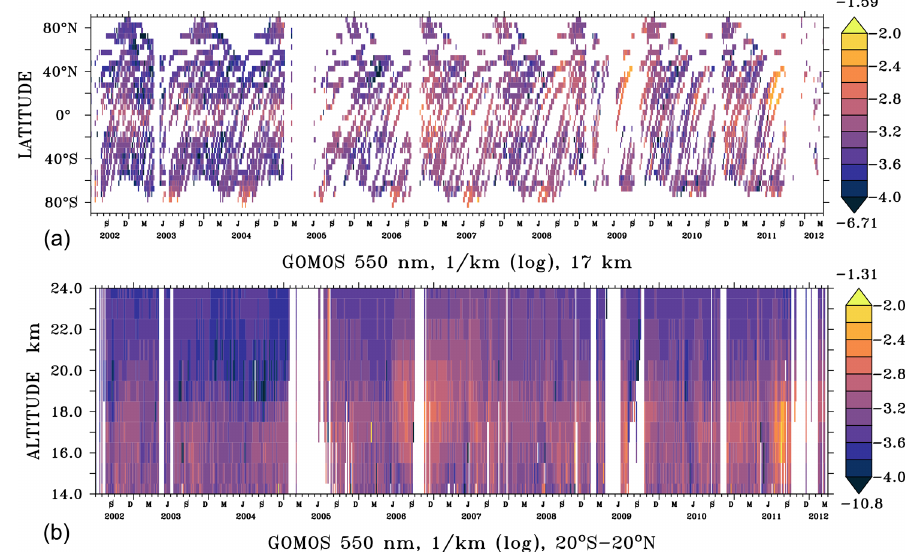
Figure 2. The decadal logarithm (log) of the aerosol extinction coefficient (km − 1 ) as derived from the GOMOS instrument data v.3.00 at a 550nm wavelength from Bingen et al. (2017). The dataset spans the period 15 April 2002–8 April 2012 (5d averages). Horizontal distribution at 17km altitude (a) and vertical distribution for tropical regions 20 ◦ S–20 ◦ N (b) . Maximum and minimum values appear above (yellow) and below (dark blue) the colour keys, respectively. White: no data.